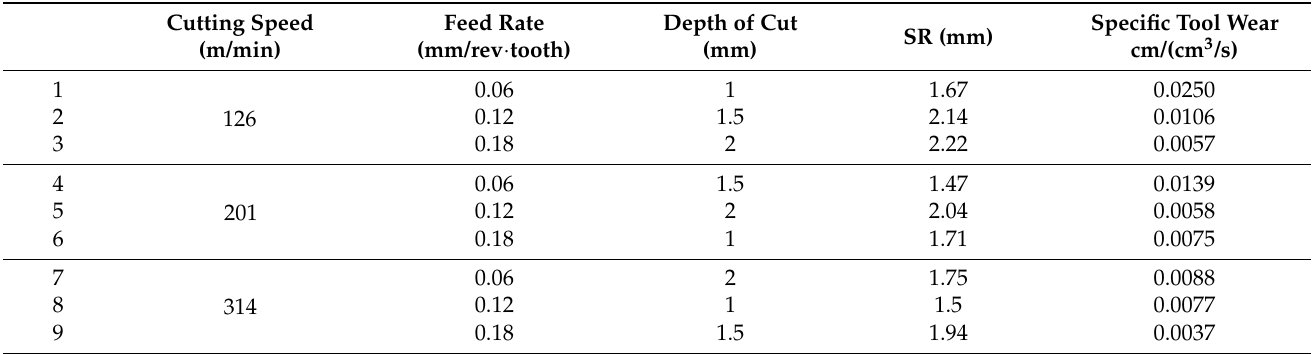
Table 1. Practical test results with 9 replications based on Taguchi L 9 orthogonal array using cutting process parameters consisting of feed rate, cutting speed, and depth of cut with corresponding to the obtained specific tool wear and surface